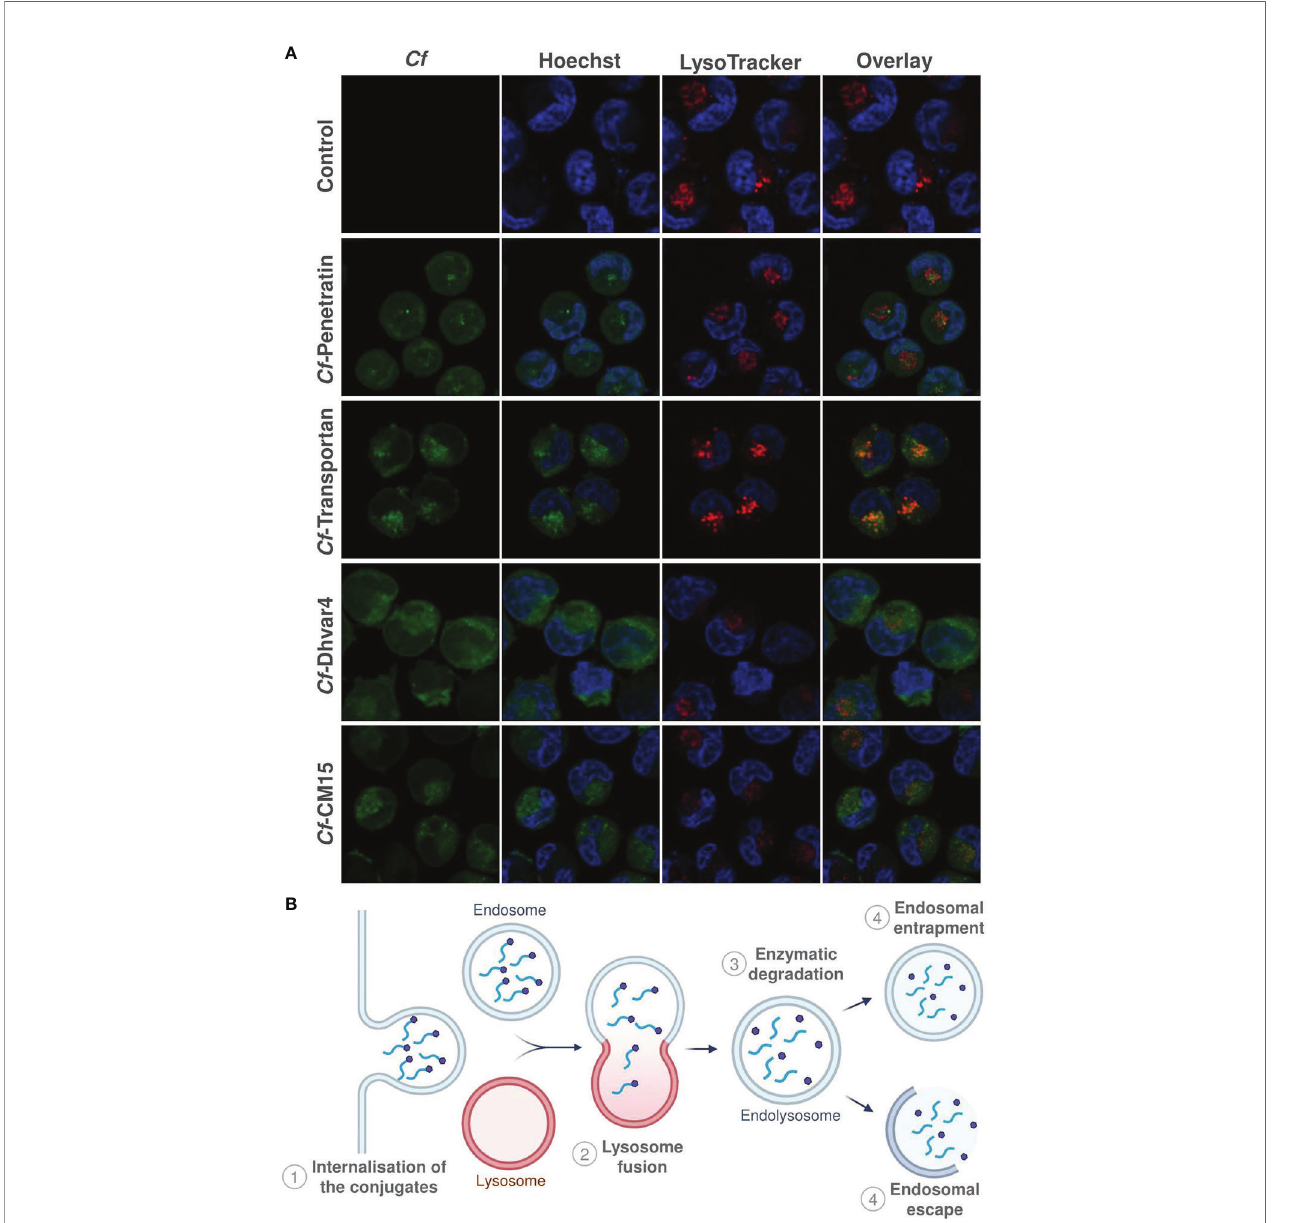
FIGURE 6 | Intracellular localization of Cf -peptides. MonoMac-6 cells were treated with the peptides at 10 µM concentration for 2 h, then cells were captured by confocal laser scanning microscopy (Zeiss LSM-710 system) (A) . LysoTracker ™ Deep Red was used for lysosome and Hoechst 33342 for nuclear staining. Schematic representation of internalization and endosomal entrapment/release processes is presented in (B)